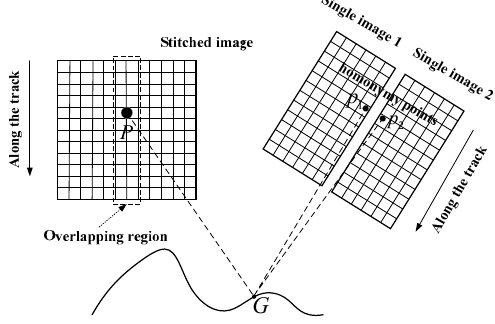
Figure 3. Consistency of the homonymy points positioning accuracy.